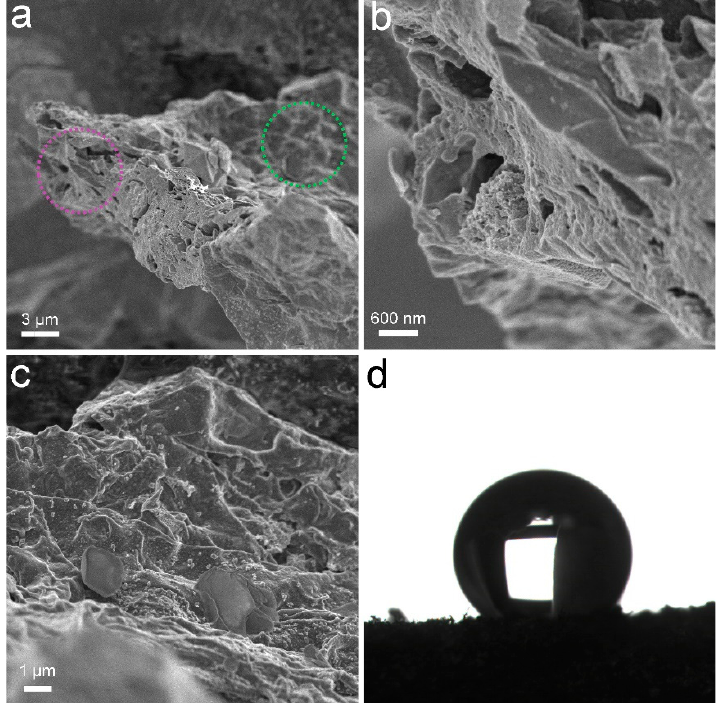
Figure 1. Characterization data of PCS. ( a – c ) SEM images; ( b ) Enlargement of the purple cycle; ( c ) Enlargement of the green cycle; ( d ) Contact angle.